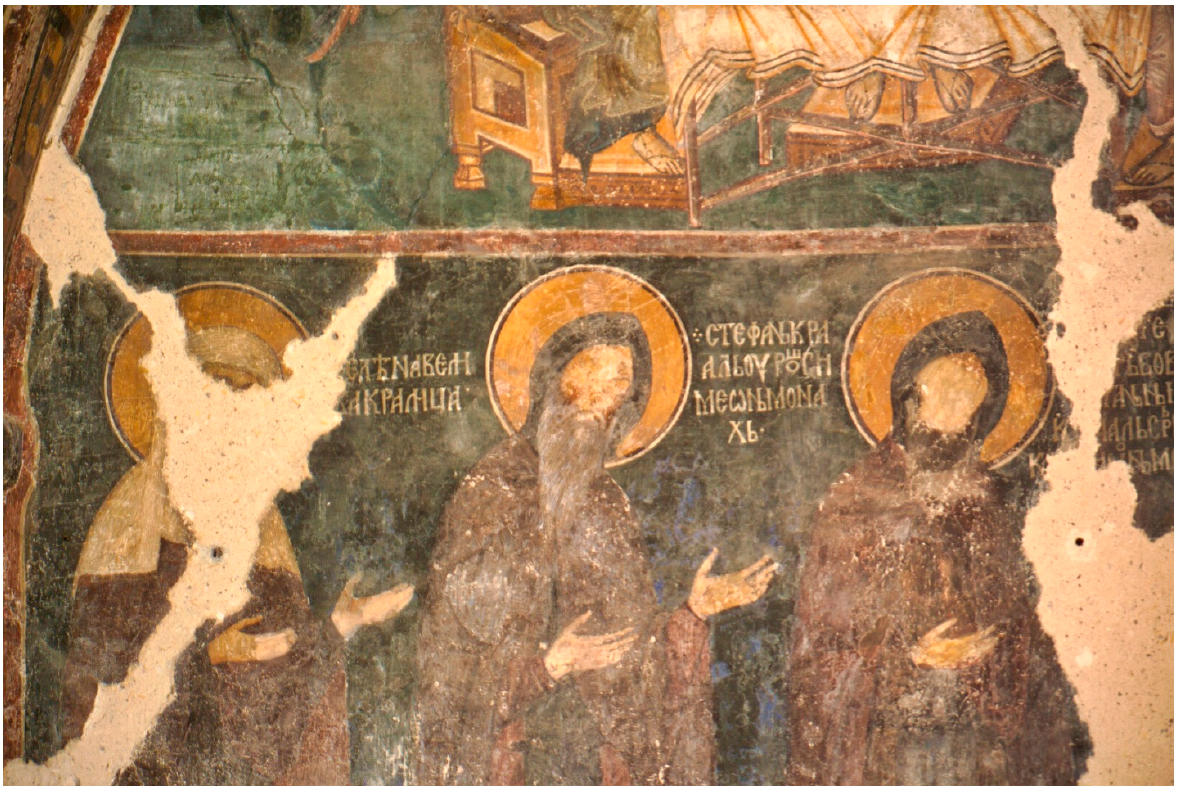
Figure 7. Queen Helen as a widow or novice, procession of Nemanide-monks, after 1282–1283, Monastery of St. George’s Pillars, Chapel of King Dragutin, south wall. Photo Nenad Vuki ć evi ć